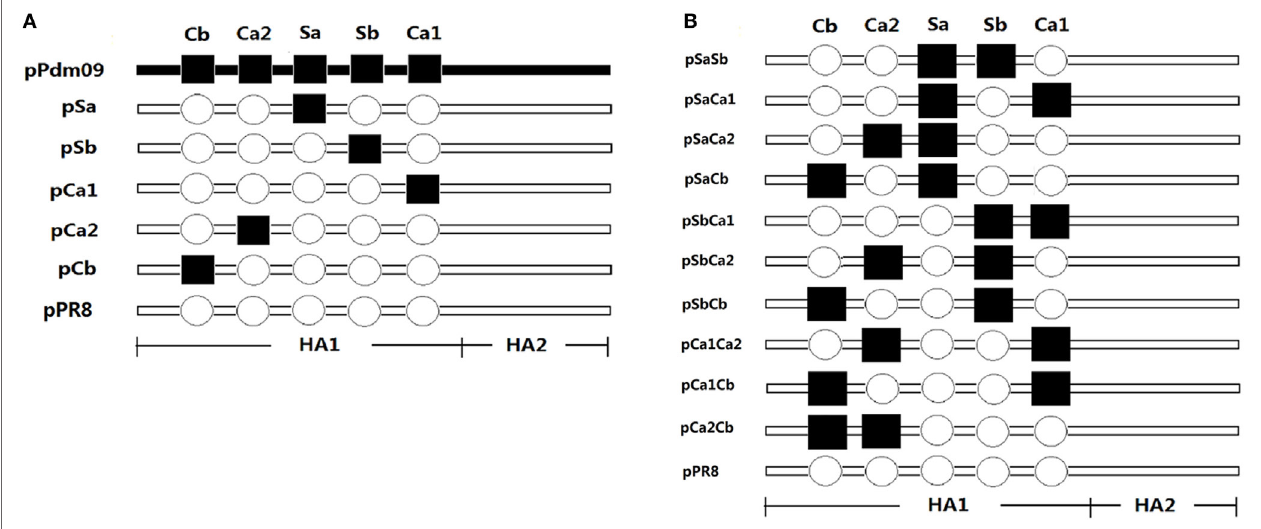
FigUre 1 | Schematic diagram of the plasmid DNAs. Plasmids pCAGGSP7/Pdm09 HA (pPdm09) and pCAGGSP7/PR8 HA (pPR8) were constructed by inserting full-length hemagglutinin (HA) gene from the Pdm09 and PR8 influenza virus, respectively, into the eukaryotic expression vector pCAGGSP7. Hollow circles denote epitopes of PR8 HA, while filled squares denote corresponding epitopes of Pdm09 HA. Plasmid pPR8 was chosen as a recipient HA backbone and DNA fragments containing epitopes of the Pdm09 HA were synthesized to replace of the corresponding epitope sequence in pPR8. (a) Plasmid DNAs substituted with one epitope of the Pdm09 HA was constructed and denoted pSa, pSb, pCa1, pCa2, and pCb. (B) Plasmid DNAs substituted with two epitopes of the Pdm09 HA were constructed and denoted pSaSb, pSaCa1, pSaCa2, pSaCb, pSbCa1, pSbCa2, pSbCb, pCa1Ca2, pCa1Cb, and pCa2Cb.